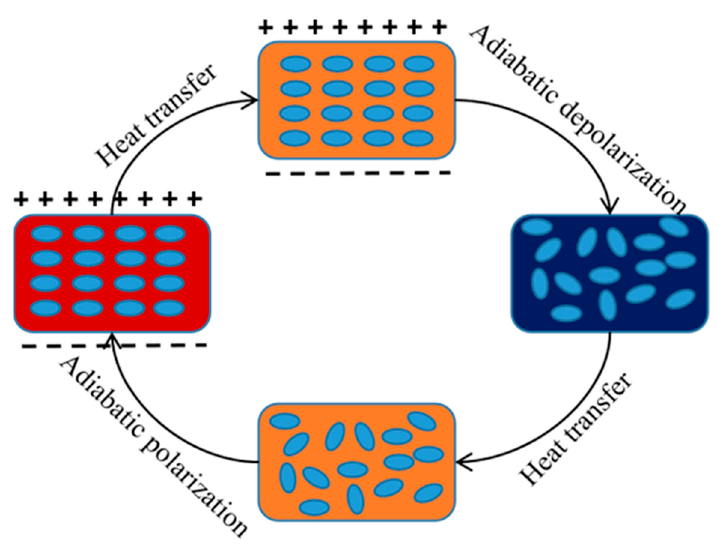
Figure 1. Positive electrocaloric effect of EC material.